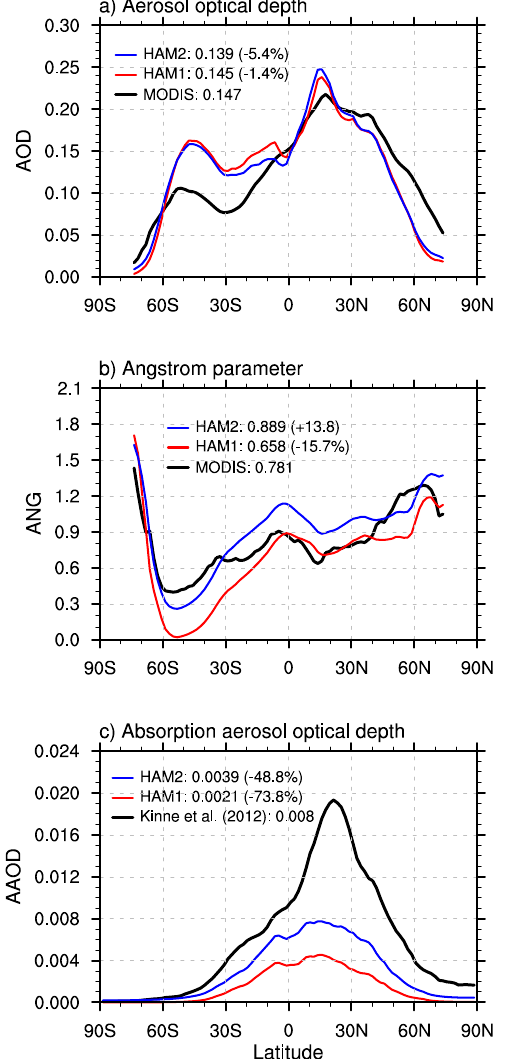
Fig. 17. Comparison of the simulated annual and zonal mean aerosol radiative properties with (a) MODIS aerosol optical depth (AOD), (b) MODIS ˚Angstr¨om parameter (ANG), and (c) aerosol absorption optical depth (AAOD) from Kinne et al. (2012). Num- bers given in legends are the global mean values and relative differ- ences. Polar Regions (75 ◦ N/S poleward) are excluded for AOD and ANG because of the limited number of satellite retrievals.